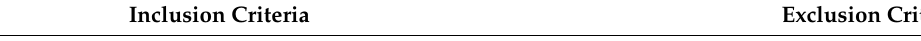
Table 1. Inclusion and exclusion